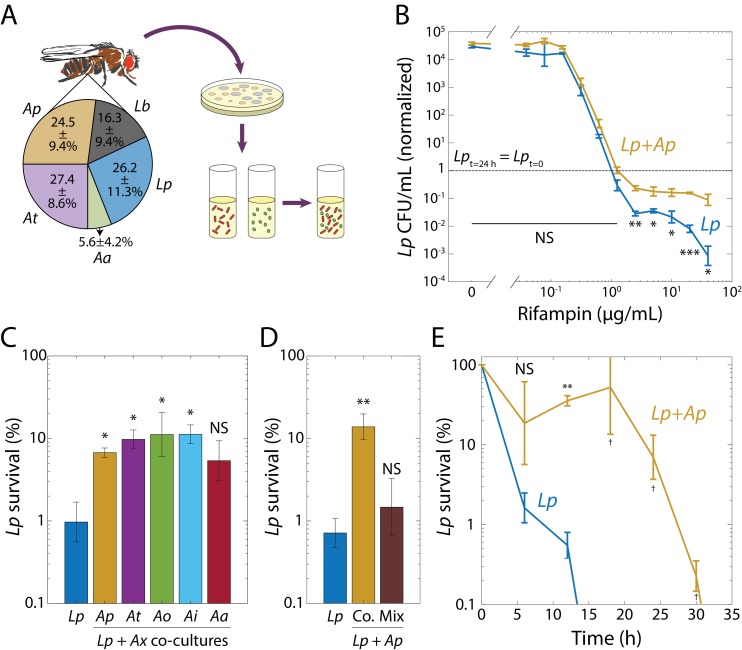
Interspecies interactions in synthetic communities derived from the fruit fly gut microbiome induce rifampin tolerance.(A) Synthetic community construction scheme. Relative abundances of the dominant species in the D. melanogaster gut microbiome determined from 16S rRNA sequencing. All reads mapped to two Lactobacillus species: L. plantarum (Lp) and L. brevis (Lb), and to three Acetobacter species: A. pasteurianus (Ap), A. tropicalis (At), and A. aceti (Aa). Values are mean ± standard deviation (S.D.), n = 18. Mean and S.D. were weighed by the total number of reads for each fly. Strains were isolated in agar plates and grown in liquid culture. Synthetic communities were then built by co-culturing individual species in liquid culture. (B) When grown with Ap, Lp survived after 24 h at rifampin concentrations above the MIC. Viable cell plating counts of Lp after growth in rifampin for 24 h normalized to the counts at the start of the experiment (t = 0, 3 × 105 and 4 × 105 CFU/mL in monoculture and co-culture, respectively). Dashed line indicates where the population at t = 24 h would have the same size as at t = 0. Error bars are S.D. for each condition, n = 3. p-values are from a Student’s two-sided t-test of the difference of the co-culture from the monoculture (*: p<4×10−3, **: p<8×10−4, ***: p<8×10−5, equivalent to *: p<0.05/n, **: p<0.01/n, ***: p<1×10−3/n, where n = 12 is the number of comparisons; NS: not significant). (C) Protection of Lp at supra-MIC concentrations of rifampin is elicited by all Acetobacter species tested. CFU/mL of Lp grown in monoculture (Lp) or in co-culture with Ap, At, A. orientalis (Ao), A. indonesiensis (Ai), and Aa, and then treated with 20 µg/mL rifampin for 24 h normalized to counts at the start of the experiment (t = 0). Error bars are S.D. for each condition, n = 3. p-values are from a Student’s two-sided t-test of the difference from the monoculture (*: p<0.01, equivalent to *: p<0.05/n, where n = 5 is the number of comparisons; NS: not significant). (D) Ap-mediated survival of Lp at rifampin concentrations above the MIC is history-dependent, requiring co-culturing before exposure as compared with mixing. CFU/mL of Lp grown in monoculture, in co-culture with Ap (Co.), or mixed with Ap without subsequent growth in the absence of antibiotic (Mix), and treated with 20 µg/mL rifampin for 24 h normalized to counts at the start of the experiment (t = 0). Error bars are S.D. for each condition, n = 3. p-vValues are from a Student’s two-sided t-test of the difference from the monoculture (**: p<5×10−3, equivalent to **: p<0.01/n, where n = 2 is the number of comparisons; NS: not significant). (E) The time to killing of Lp under rifampin treatment is extended in the presence of an Acetobacter. CFU/mL of Lp grown in monoculture and co-cultured with Ap, and treated with 50 µg/mL rifampin, normalized to counts at the start of the experiment (t = 0). Error bars are S.D. for each condition, n = 3. p-values are from a Student’s two-sided t-test of the difference from the monoculture at the corresponding timepoint (**: p<2×10−3, equivalent to **: p<0.01/n, where n = 5 is the number of comparisons; †: measurement below limit of detection; NS: not significant). Values off the graph were below the limit of detection of the assay.